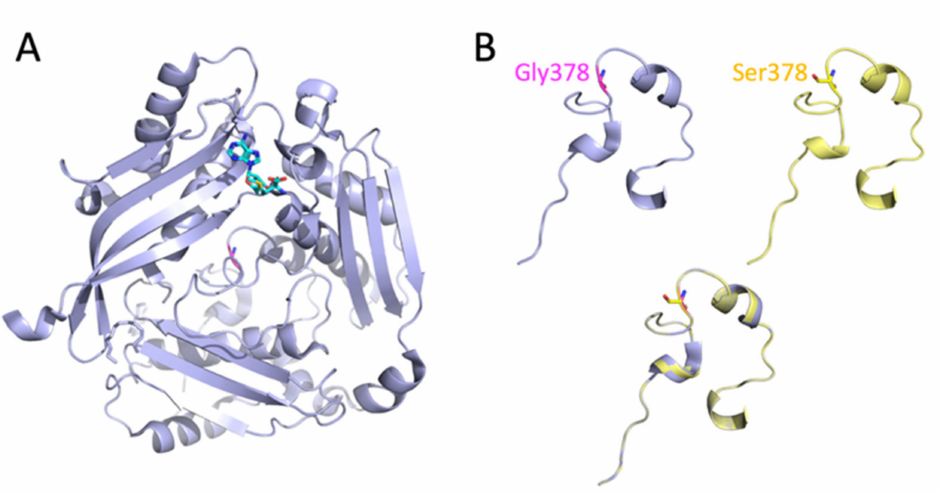
Figure 3. Structure of monomeric human MAT1A. ( A ) Monomeric MAT1A (PDB 2OBV) is shown as light blue ribbons, with AdoMet represented as sticks shown in cyan. Target residue Gly378 is located in the C-terminal region of MAT1A within loops and β -turns, and is herein shown as magenta sticks. ( B ) Close up of the location of Gly378 within the C-terminus of MATA1 in wild-type MAT1A (light blue), results from in silico mutagenesis to Ser (yellow), and alignment of native (Gly378) and mutant (Ser378) MAT1A proteins (overlay, light blue and